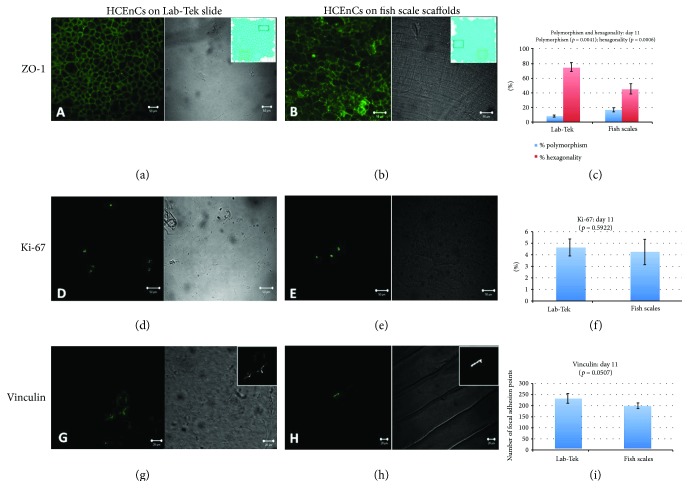
Expression of different proteins in cultured HCEnCs on Lab-Tek and FSS. ZO-1 staining for intracellular tight junctions to determine polymorphism and hexagonality of the cells in (a) Lab-Tek and (b) in FSS. Figure inserts show the overlay masks of the expression for calculation of hexagonality and polymorphism (polymegathism and pleomorphism). (c) High percentage of polymorphism (p = 0.0041) and low percentage of hexagonality (p = 0.006) were observed when HCEnCs were cultured on FSS compared to Lab-tek slides. (d) Proliferative cells did not differ when the HCEnCs were cultured in (e) Lab-Tek and FSS and (f) did not show statistical significance (p = 0.5922). (g) Vinculin as a focal adhesion marker showed a higher number of focal adhesions when HCEnCs were cultured on Lab-Tek compared to that on (h) FSS which was (i) marginally significant (p = 0.0507). Figure inserts show the amount of vinculin expressed (number of focal adhesions) which was counted using binary images. HCEnC: human corneal endothelial cell; FSS: fish scale scaffold.